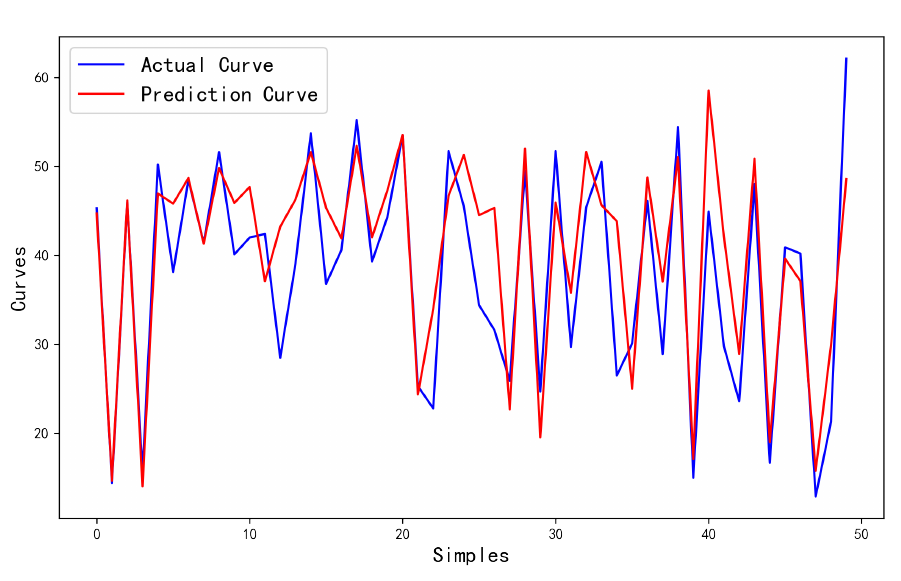
Figure 11. The regression fitting curve for Estate test set.